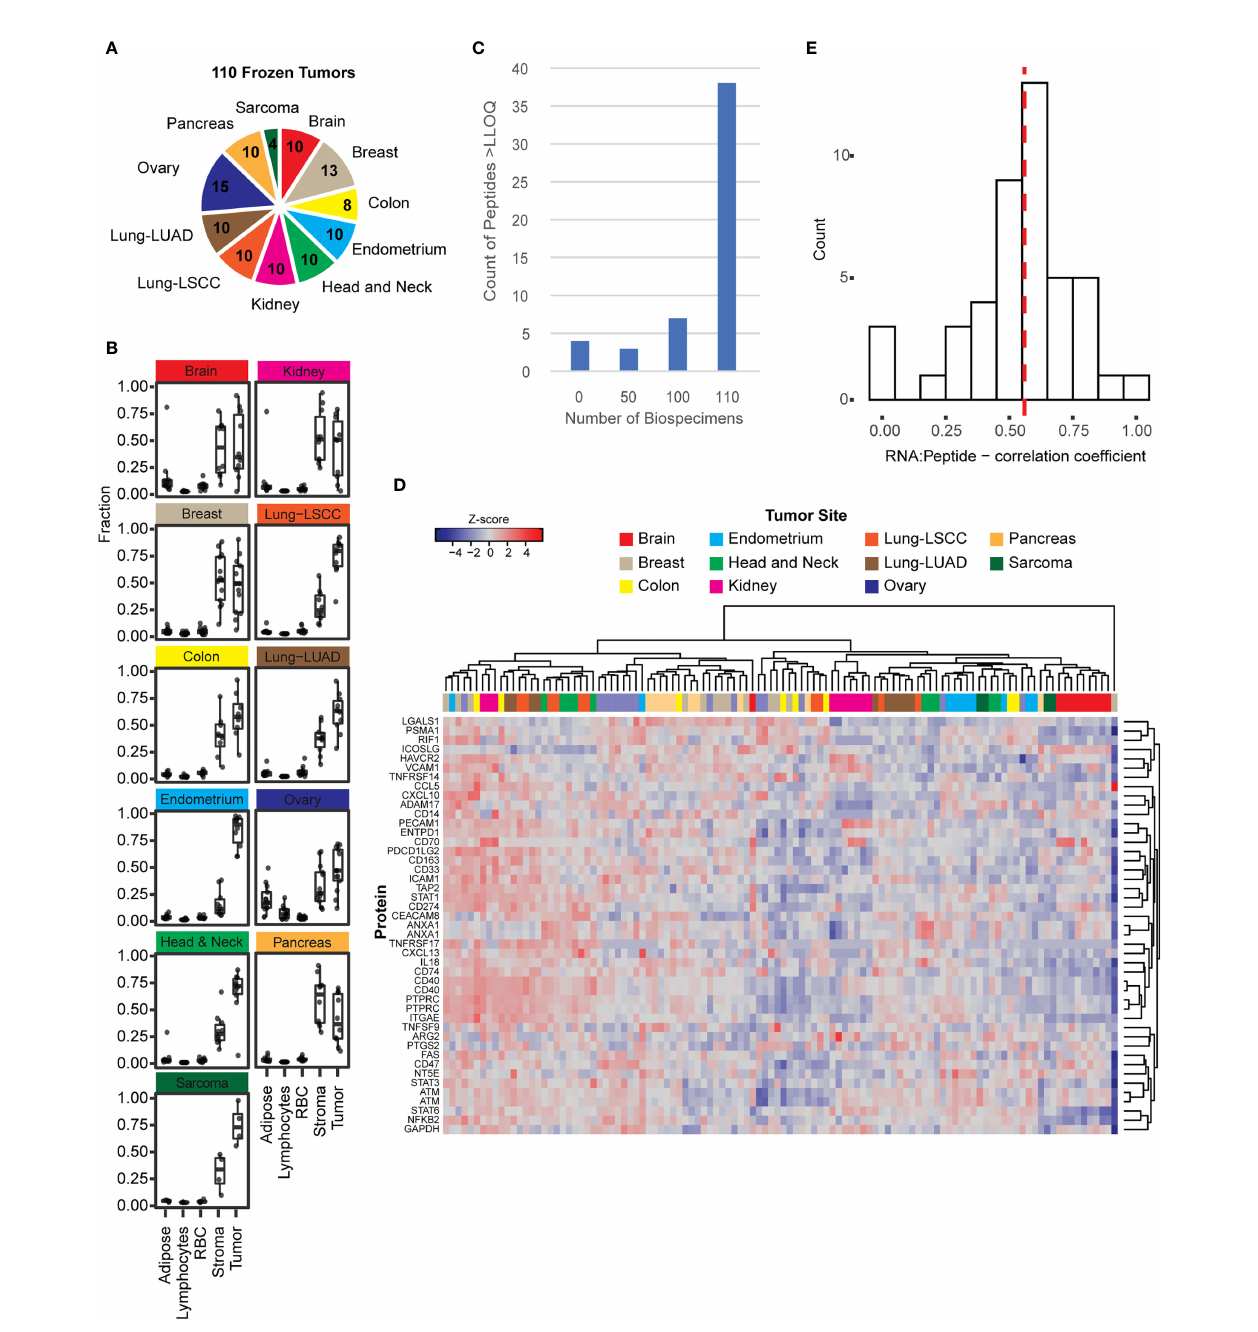
FIGURE 2 | The immuno-MRM assays show detection in frozen tissues. (A) Frozen tissues were obtained for 110 tumors from 11 tumor types. The number of each type is indicated in the pie chart. (B) The relative fractions of adipose, lymphocytes, red blood cells, stroma, and tumor cells were plotted for tumors with available images (108 out of 110). Cellular microheterogeneity was determined by using the HALO algorithm. Each point represents an individual tumor. Box plots show median (line), inner quartiles (box), and 5-95% range (vertical lines). (C) Distribution of peptide detection plotted as a histogram, showing the number of peptides detected above LOQ across the 110 frozen tumors. (D) Heatmap showing unsupervised clustering of analytes detected above LOQ in > 50% of tumor specimens. Peak area ratios (light:heavy) were normalized for each peptide analyte, and the z-score was used for clustering. (E) Histogram showing correlation of protein expression measured by immuno-MRM with mRNA transcript level determined by RNAseq (52). The median is indicated by a dotted line